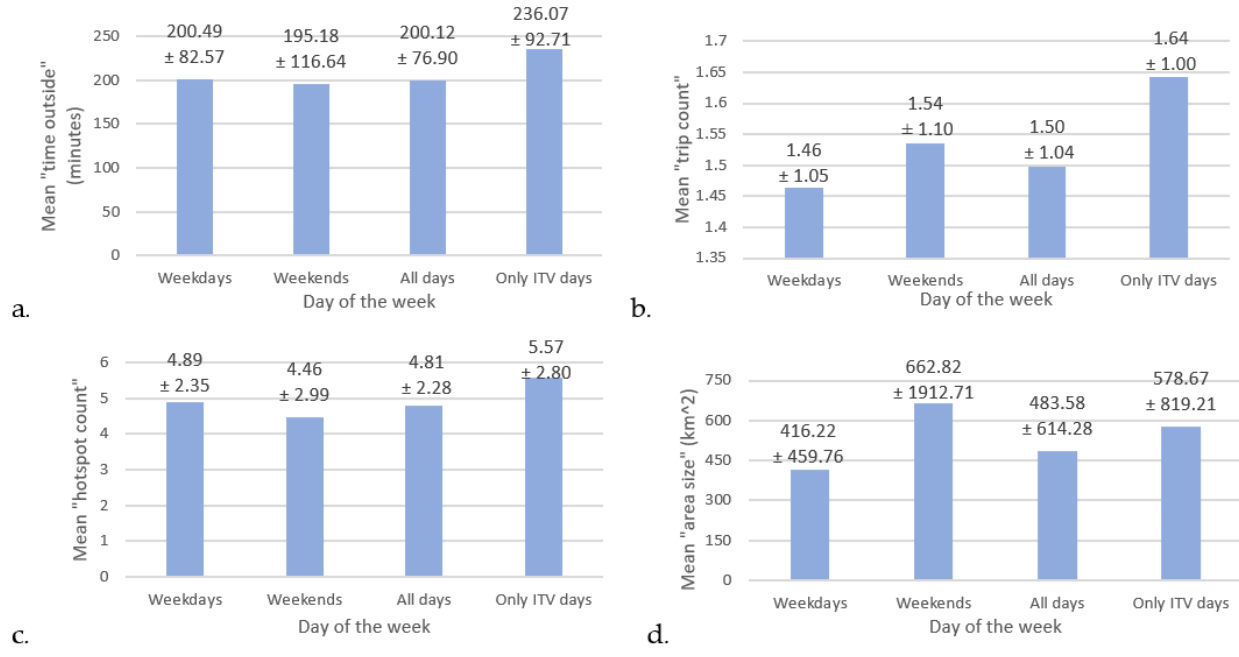
Figure 2. Variations in mean mobility outcomes occurred depending on when sampling occurred during the week and which days were included in the calculations. Mean weekday to weekend change occurred in ( a ). “time outside” (minutes; − 2.72% from weekday to weekend), ( b ). “trip count”